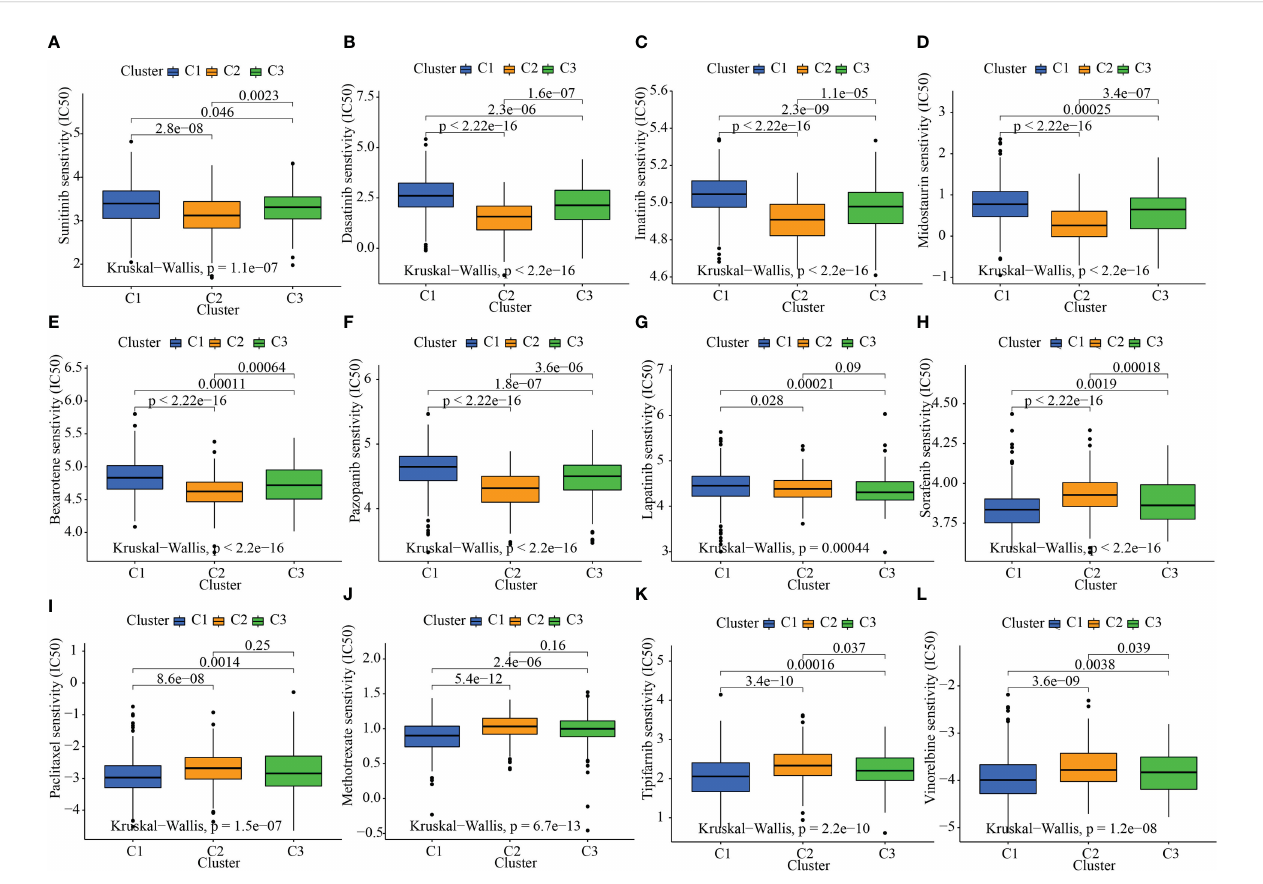
FIGURE 6 The link between sensitivity to pharmaceuticals and clusters of oxidative metabolism. The box plots of the predicted IC50 values for twelve different kinds of commonly used chemotherapy drugs are displayed in (A – L) for cluster 1 (blue), cluster 2 (yellow), and cluster 3 (green). The following are the 12 different kinds of chemotherapy-related drugs: Sunitinib, Dasatinib, Imatinib, Midostaurin, Bexarotene, Pazopanib, Lapatinib, Sorafenib, Paclitaxel, Methotrexate, Tipifarnib, and